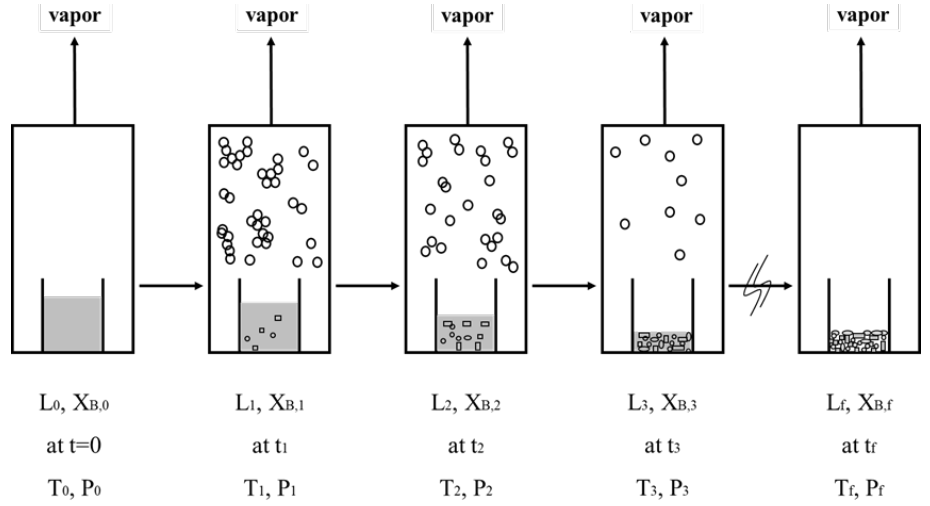
Figure 4. Schematic diagram of a batch SC experiment, where each stage corresponds to a three- phase transformation state at a given time: at 𝑡 = 0 , a liquid mixture in the sample container; at 0 < 𝑡 < 𝑡 𝑓 , formation of the solid product and mixture vapor from a liquid mixture due to the three- phase transformation; at 𝑡 𝑓 , only the solid product and the remaining liquid contained in the sample container. Note that the vapor is condensed and collected outside the sample container in the cham- ber.